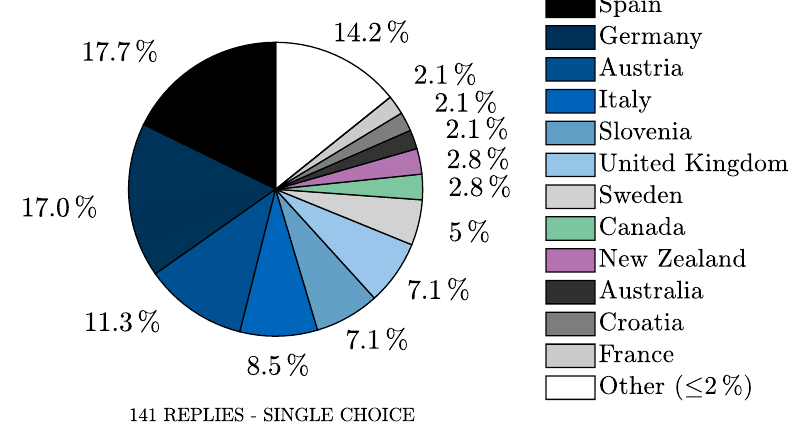
Figure 6. Origin of the